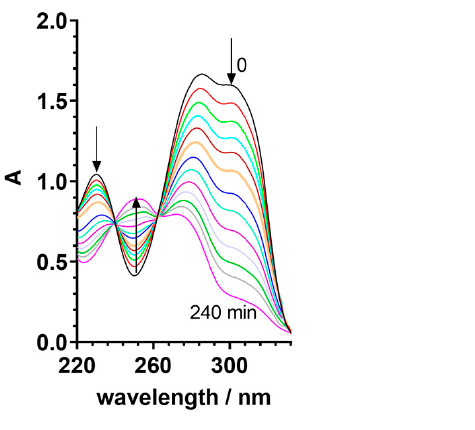
Figure 2. ( a ) UV spectra of 8-TG (c = 1.8 × 10 − 4 M) in air-equilibrated aqueous solution before (black) and after 240 min. Irradiation at λ = 313 nm, ( b ) Chromatogram of the solution of 8-TG before (red) and after irradiation (black).